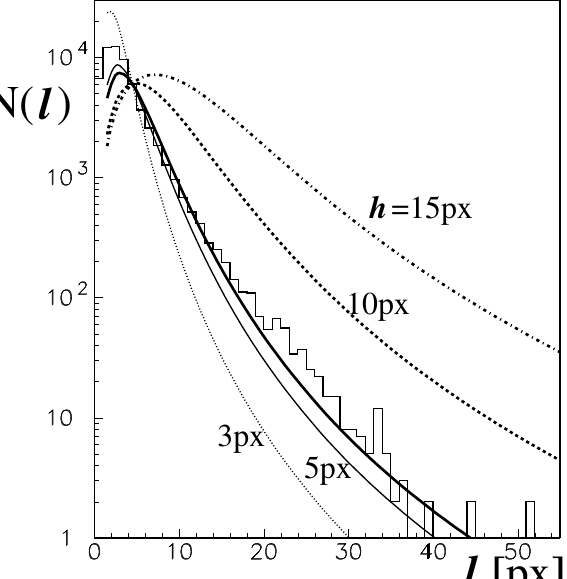
Figure 4. Measured track length distribution. Lines are shown for comparison with the predictions calculated for various values of smartphone camera matrix sensitive layer thickness ( h ) measured using individual pixel size (px): 3 px—dotted line, 5 px—thin continuous line, 10 px—dashed line, and 15 px—dot-dashed line. The thick solid line represents the result of our best fitted h (details in the text). On the abscissa, the value of the trace length measured, again, in the pixels size (px) is shown. All distributions are normalized at one point ( l = 5